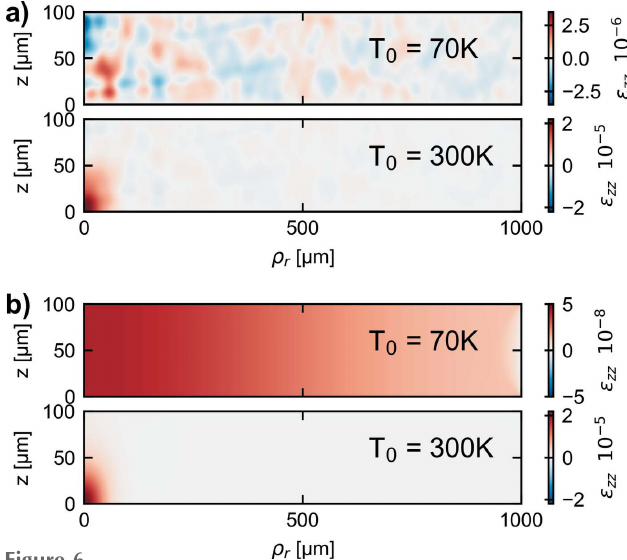
Figure 6 Normal strain in the z -direction after 222.22 ns. ( a ) Thermoelastic simulation. ( b ) Quasi-static simulation using the temperature profile given after 222.22